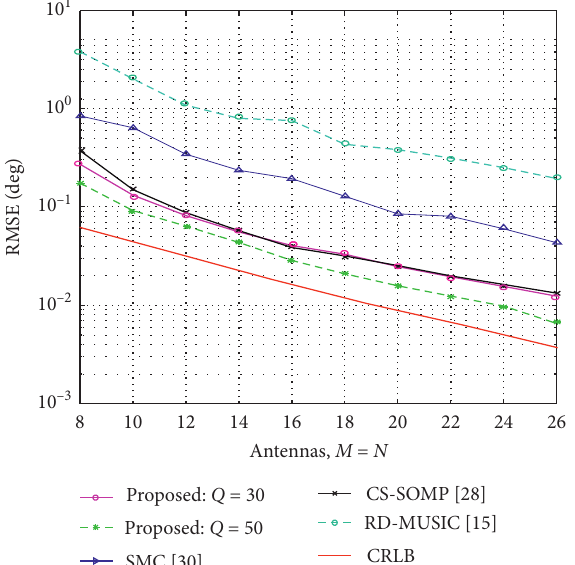
Figure 6: RMSE against number of